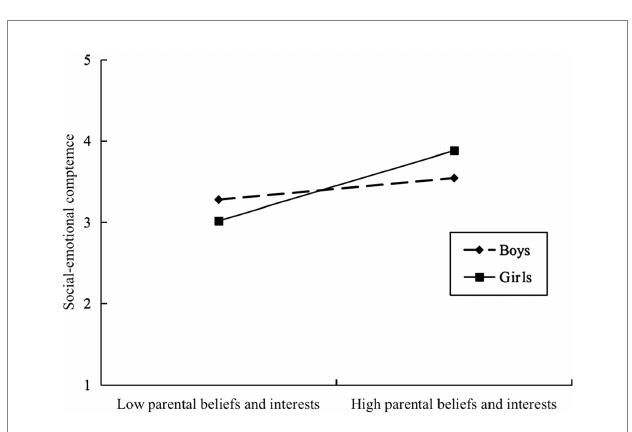
FIGURE 6 The moderating effect of children’s gender on the relationship between parental beliefs and interests and children’s social–emotional competence: Simple slope for a Model A, the pick-a-point